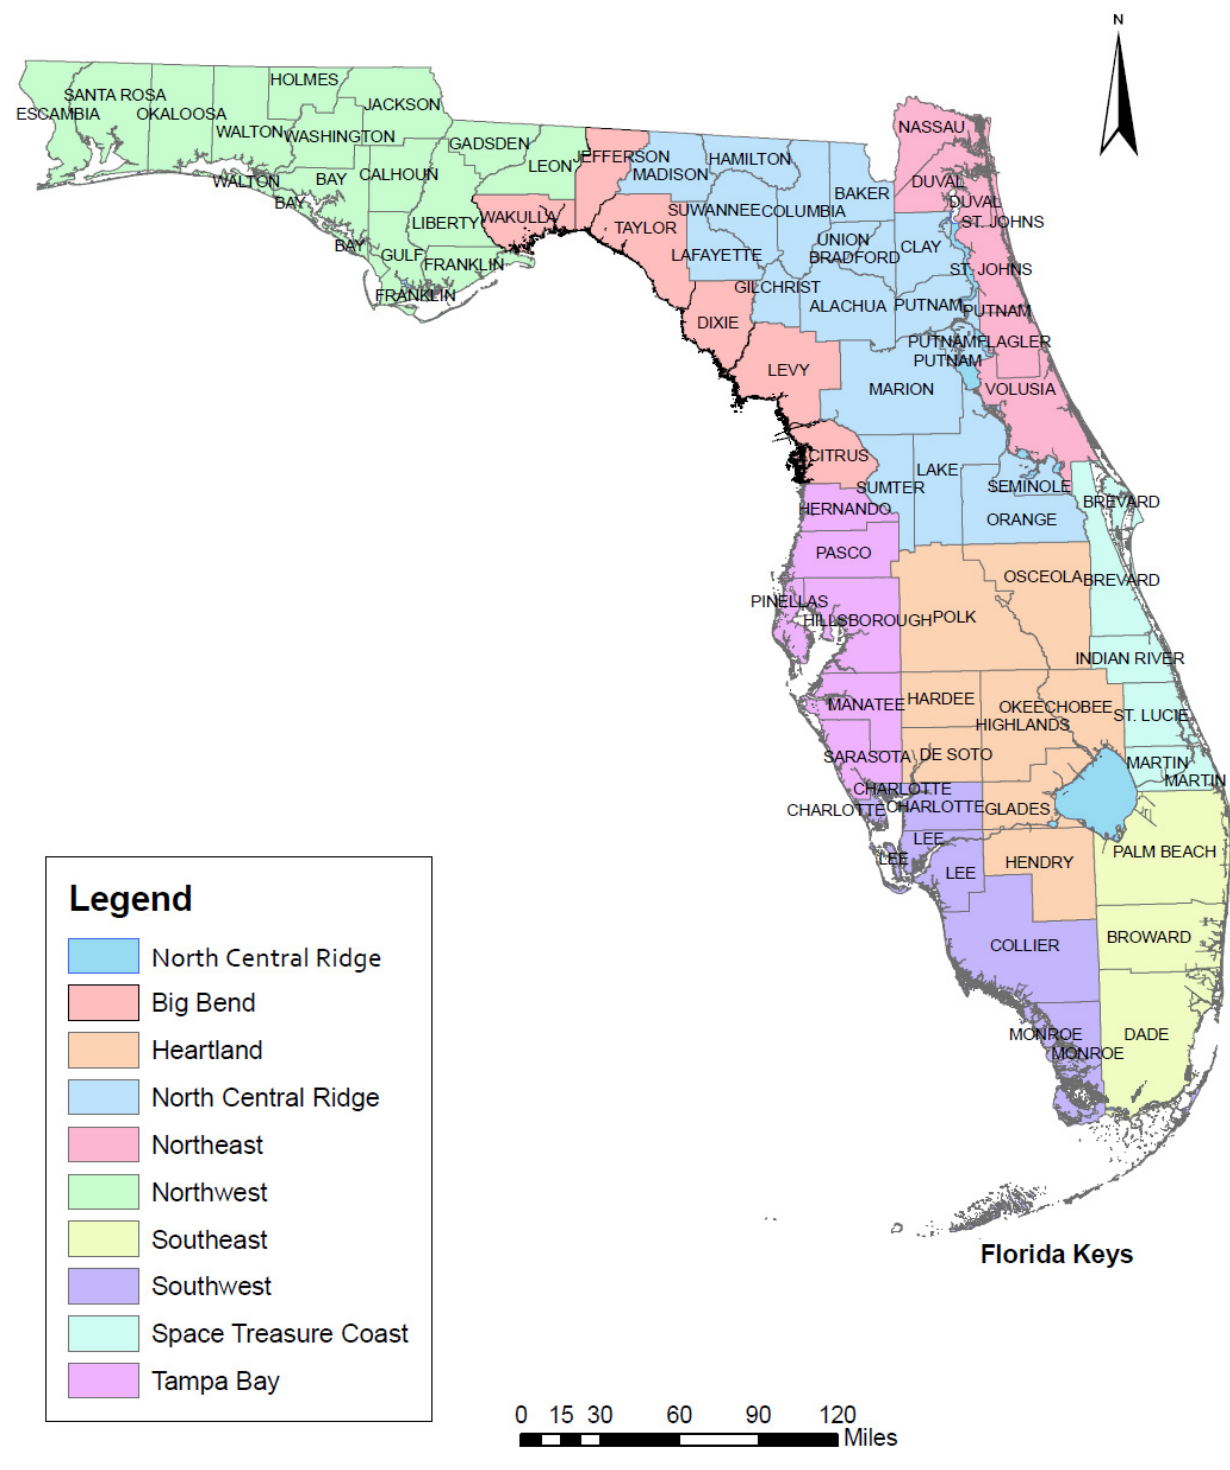
Figure 3. Areas of the